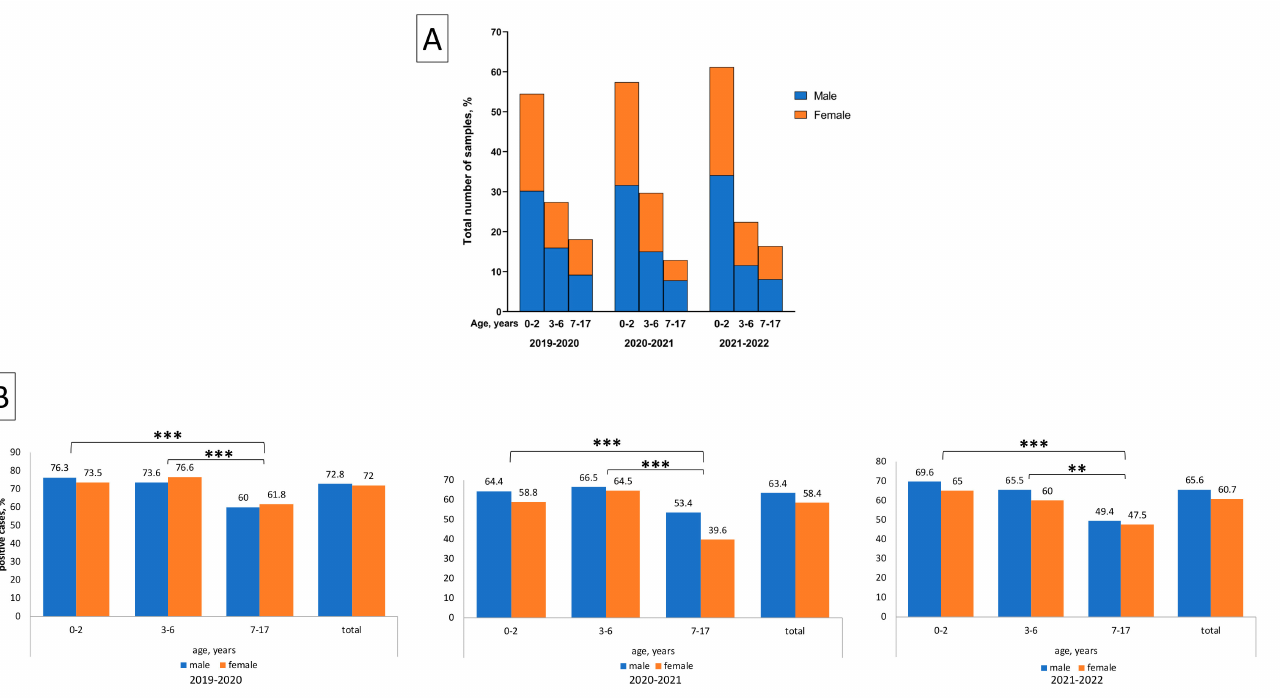
Figure 1. Age and gender distribution data from a total of 3190 children and adolescents hospitalized with acute respiratory infections in 2019–2022. ( A ) PCR-confirmed samples from children aged 0–17 years ( B ) Age and gender distribution data by the three successive research periods: the